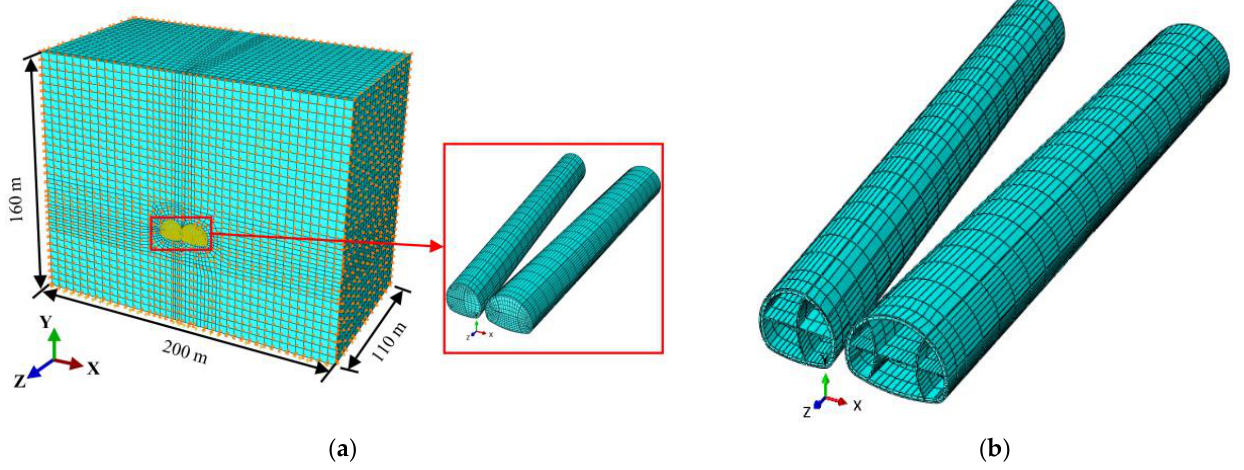
Figure 3. Numerical calculation model: ( a ) Overall numerical model; ( b ) Tunnel